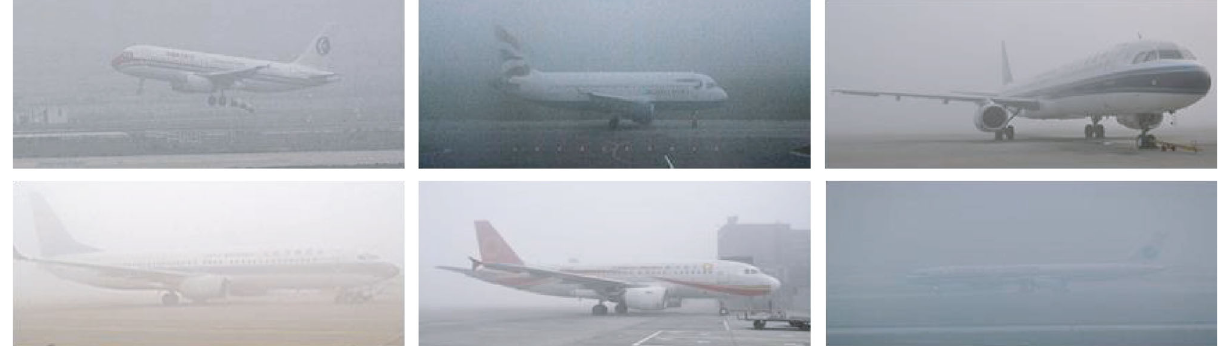
Figure 1: Filtered sample original